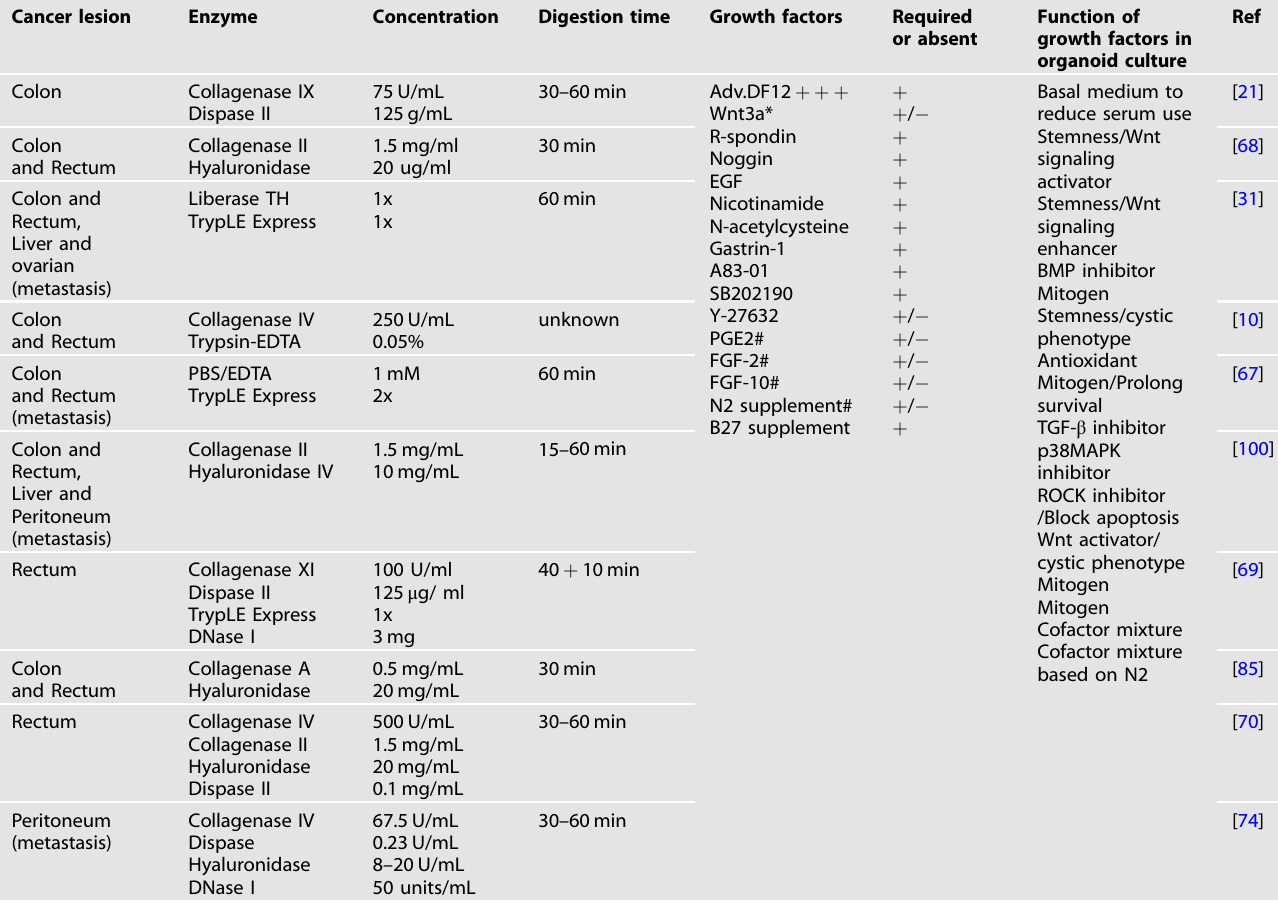
Table 1. Culture systems for colorectal cancer